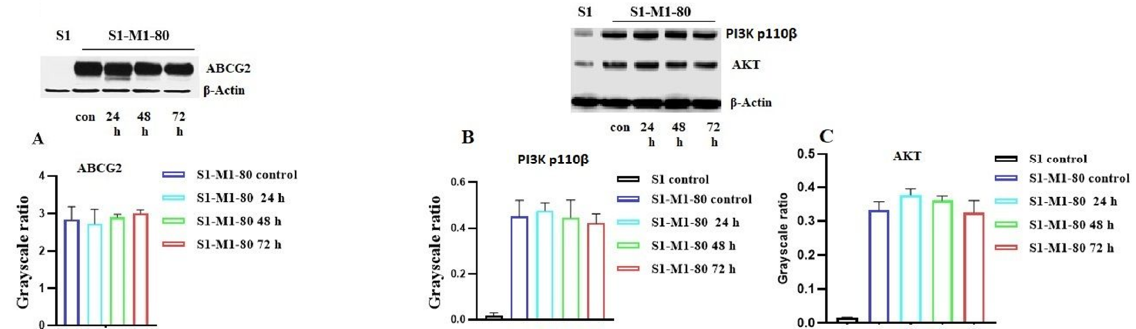
Figure 5. The effect of VKNG-2 on the expression of the ABCG2, PI3K p110 β and AKT protein. The effect of VKNG-2 on the expression of the ABCG2, PI3K p110 β and AKT protein were determined in S1-M1-80 colon cancer cells following incubation with vehicle (Control) or 5 µ M of VKNG-2 for 24, 48 or 72 h ( A – C ). Equal amounts of total cell lysates were used for each sample and a Western blot analysis was